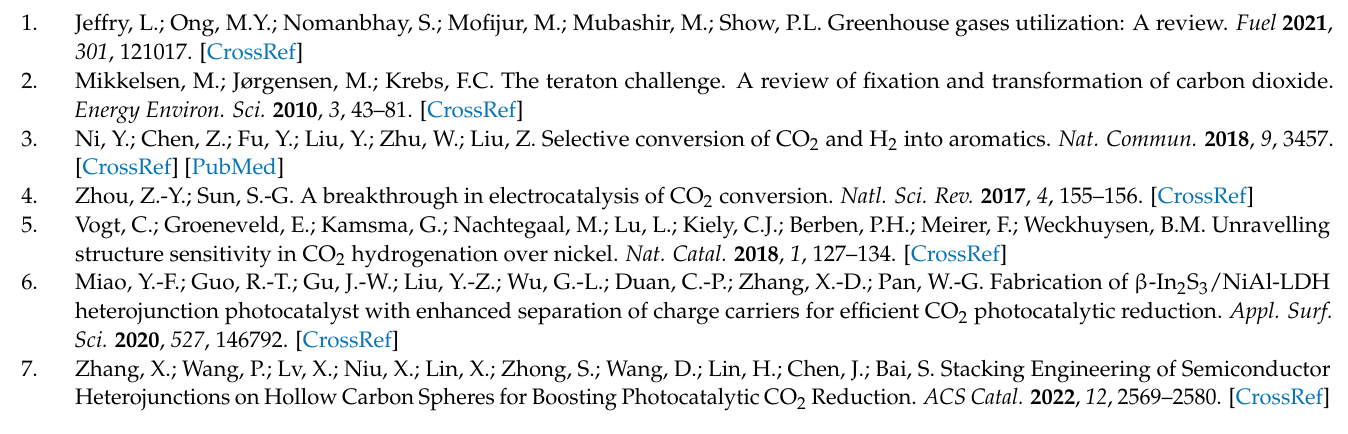
PdAg. Figure S4: 1 H NMR spectra of the liquid conversion products for Pd 3 Ag alloy after electrolysis for 1 h at − 0.2 V(vs. RHE). Figure S5: GC spectra of the gas conversion products detected with (a) thermal conductivity detector (TCD) and (b) flame ionization detector (FID) for Pd 3 Ag alloy after electrolysis for 1 h at − 0.2 V (vs. RHE). Figure S6: Potential-dependent FE for CRR products and partial current density. Figure S7: Chronoamperometric curves for Pd 3 Ag at − 0.2 V (vs. RHE) in CRR. Figure S8: Structural characterizations of bimetallic Pd 3 Ag after long-term durability test: (a) HADDF-STEM-EDS mapping of Pd and Ag in the selected area. Elemental mapping of (b) Pd, (c) Ag, and (d) a mixed pattern of Pd and Ag; (e) the EDX spectra of the Pd 3 Ag after a long-term durability test. Table S1: Comparison of different catalysts in electrochemical CRR for HCOOH